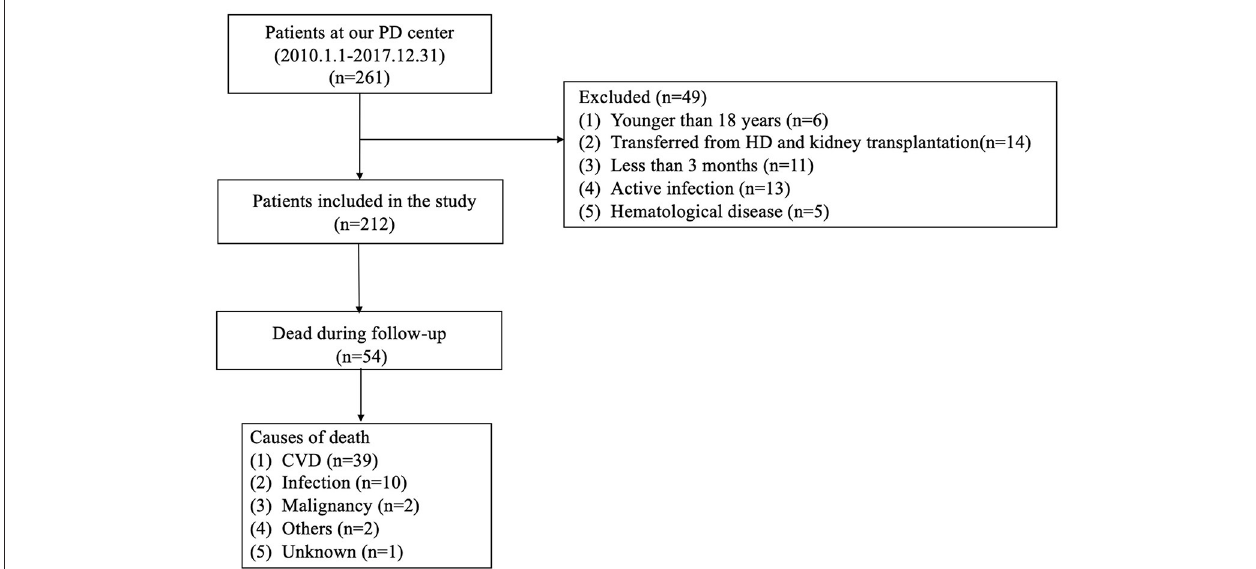
FIGURE 1 | Enrollment flowchart for analysis. PD, peritoneal dialysis; HD, hemodialysis; CVD, cardiovascular